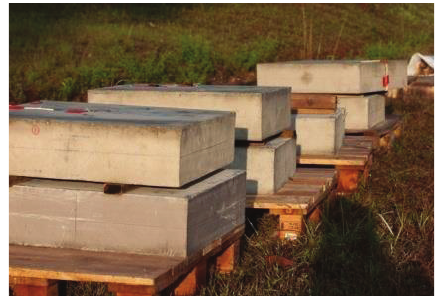
Figure 1: Reinforced concrete test panels.